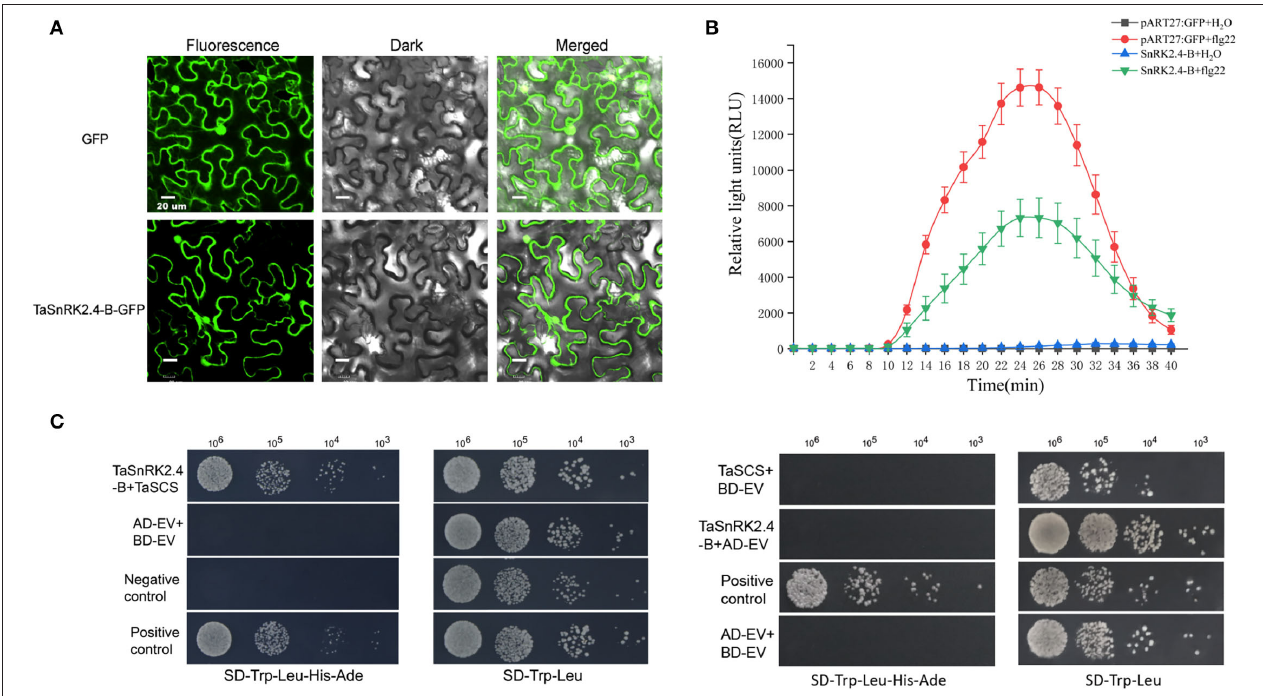
FIGURE 6 | Functional analysis of TaSnRK2.4-B. (A) Subcellular localization of TaSnRK2.4-B. GFP fluorescence was visualized using confocal laser scanning microscopy. Scale bar = 20 µ m. (B) Oxidative burst triggered by 5 × flg22 solution in transient overexpression of TaSnRK2.4-B leaves and vector control measured in a luminol-based assay as relative light units. Values are averages ± SE ( n = 12). (C) Different concentrations (cells/ml) of yeast transformants expressing the indicated bait and prey constructs were assayed for growth on SD-Trp-Leu and SD-Trp-Leu-His-Ade